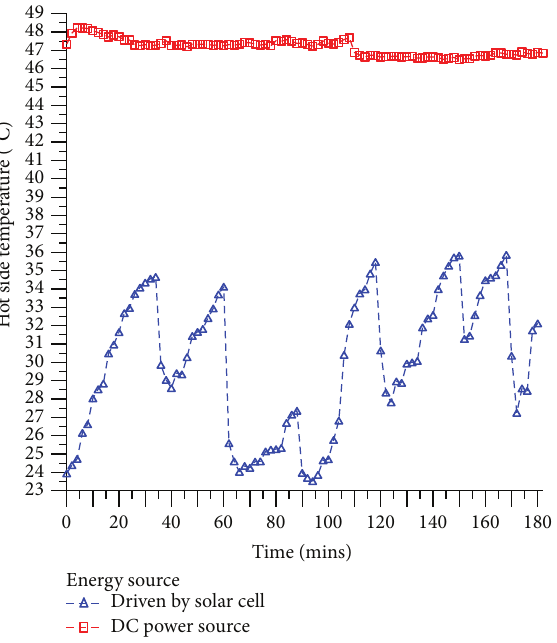
Figure 6: The hot side temperatures of the thermoelectric system by DC source and solar cells.